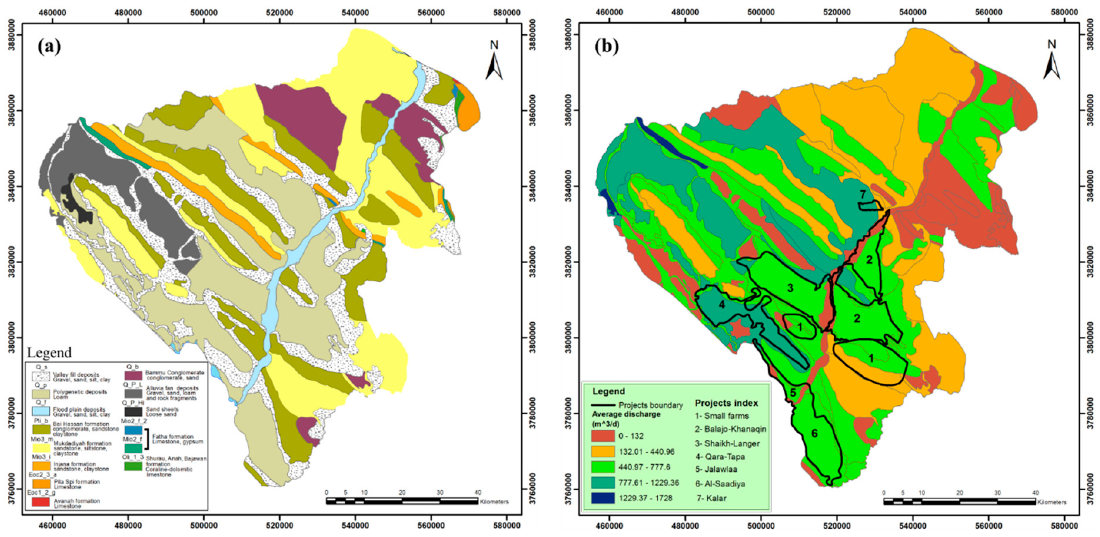
Figure 2. Geological and average aquifers discharge maps of the study area. ( a ) geological map (GEOSURV, 1993); ( b ) average aquifers discharges map extracted from the historical wells logs dataset and ArcGIS spatial analysis (UTM coordinate system).